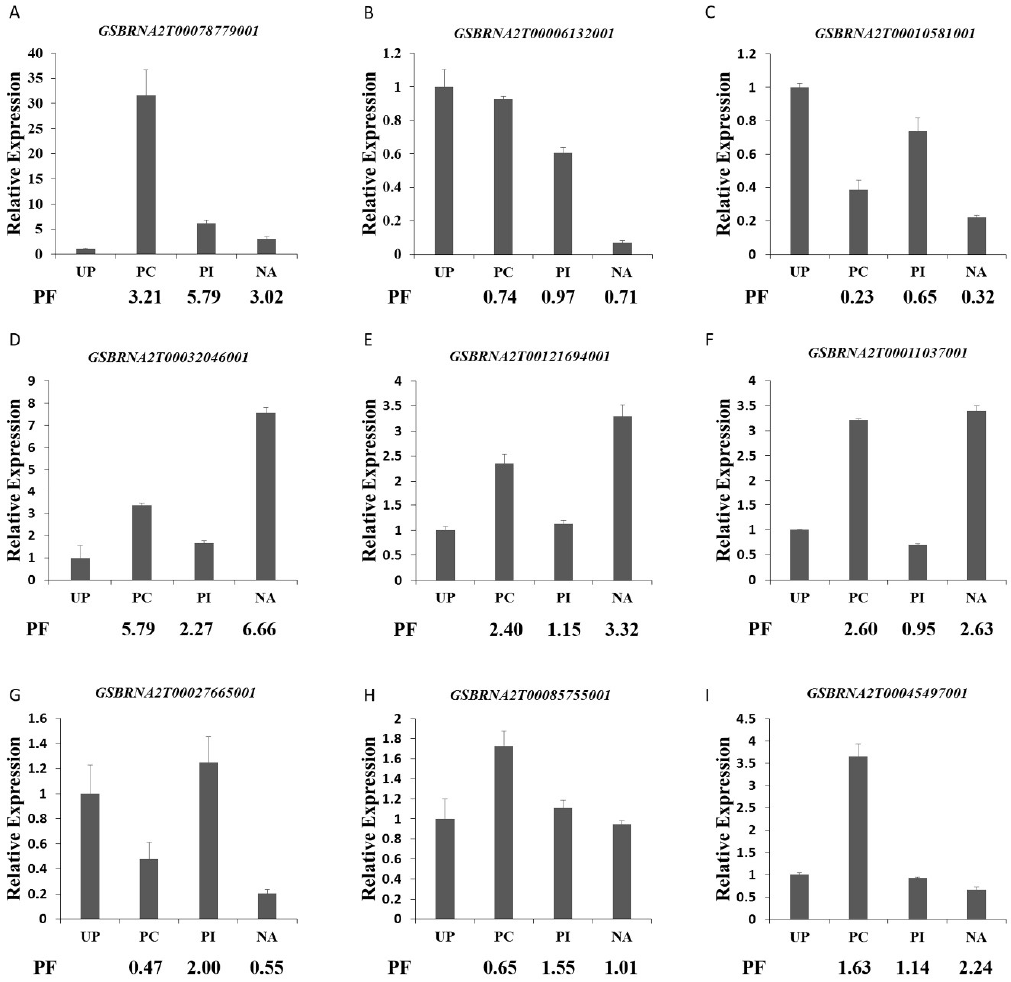
folds of UP-VS-PC, UP-VS-PI, and UP-VS-NA. Error bars indicate standard deviation.